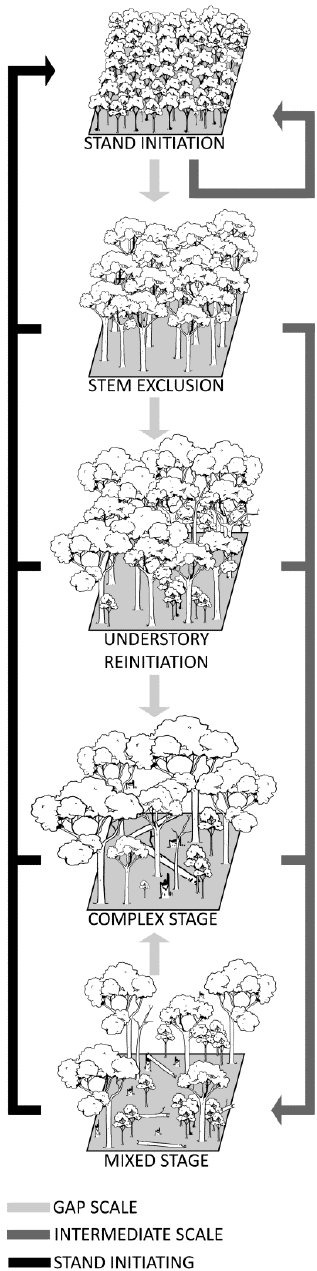
Figure 1. Model of oak stand development adapted from Johnson et al. [4] illustrating forest disturbances and their relation to stages of stand development and disturbance ‐ recovery